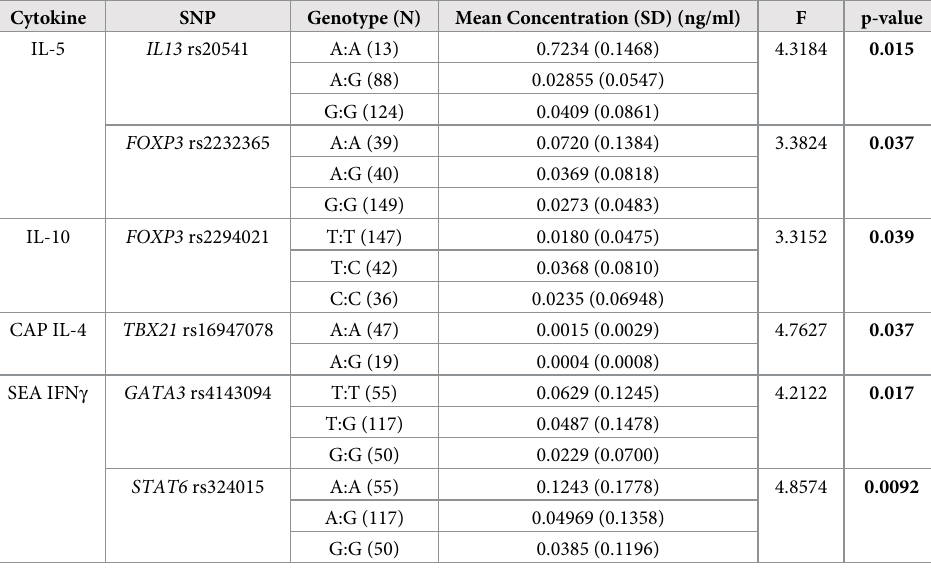
Table 5. Analysis of variance of mean cytokine concentrations between SNP genotypes.